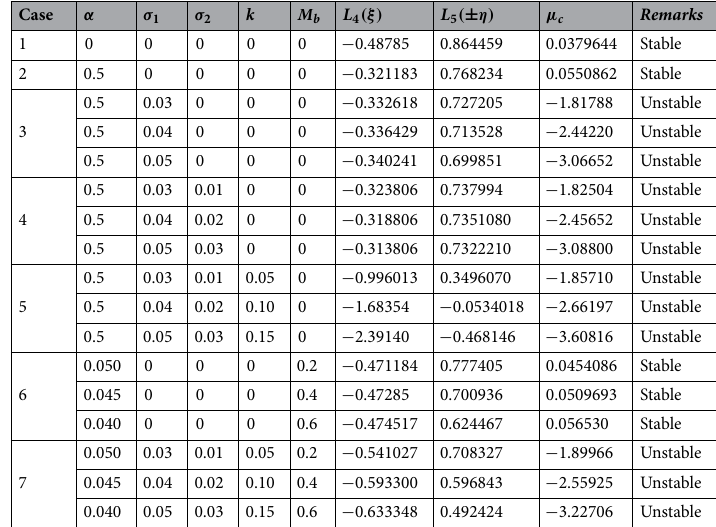
Table 5. Effects of various perturbations on the Critical Mass Value (µ c ) of the triangular libration points. 0.01215, A 0.0000003686, e (µ = =